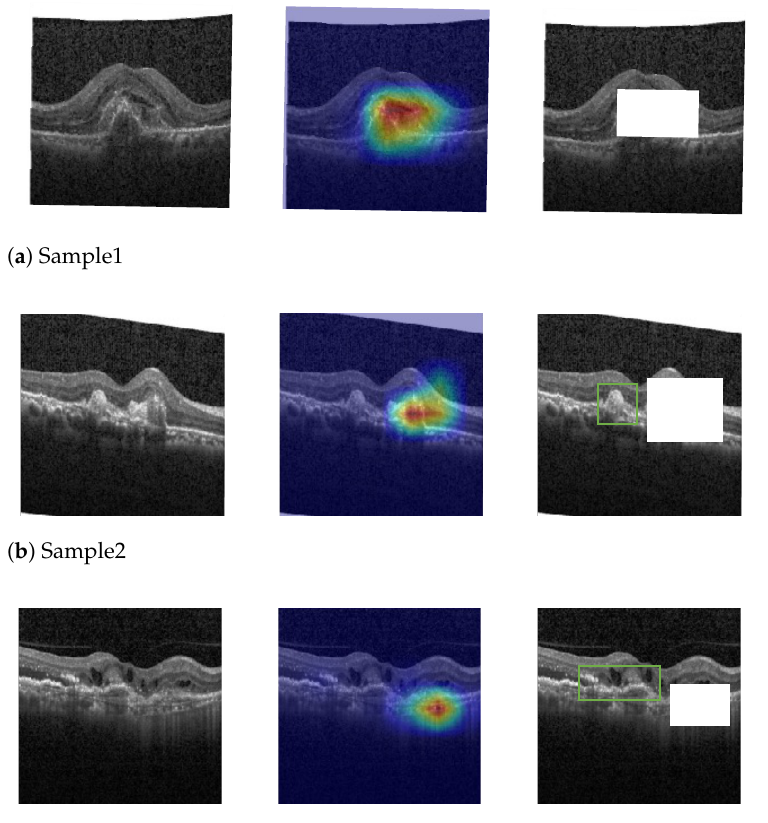
Figure 1. Three choroidal neovascularization (CNV) samples containing a neovascular membrane. Each row represents an optical coherence tomography (OCT) sample. The three columns denote the original OCT image, the visualization result of CAM, and the image with CAM masked, respectively. For the right-most image in all three rows, the white masks represent the result area of CAM, and the green squares denote the lesions ignored by DNNs. Detailed illustration of dataset and computation principle of CAM can be found in Section